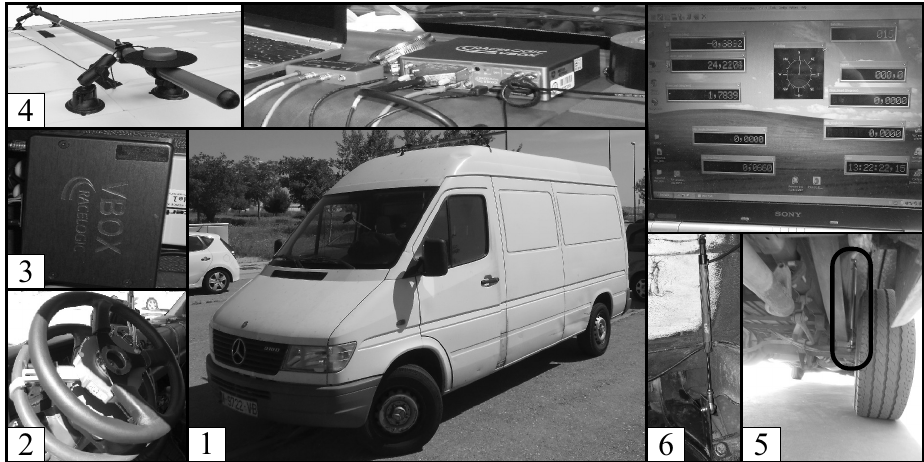
Figure 4. Experimental setup on a test vehicle. (1) Mercedes Sprinter. (2) Steering angle sensor MSW 250 Nm. (3) Vbox 3i dual antenna data logger. (4) GPS antennas. (5) LVDT MNT potentiometer. (6) SA-LP075